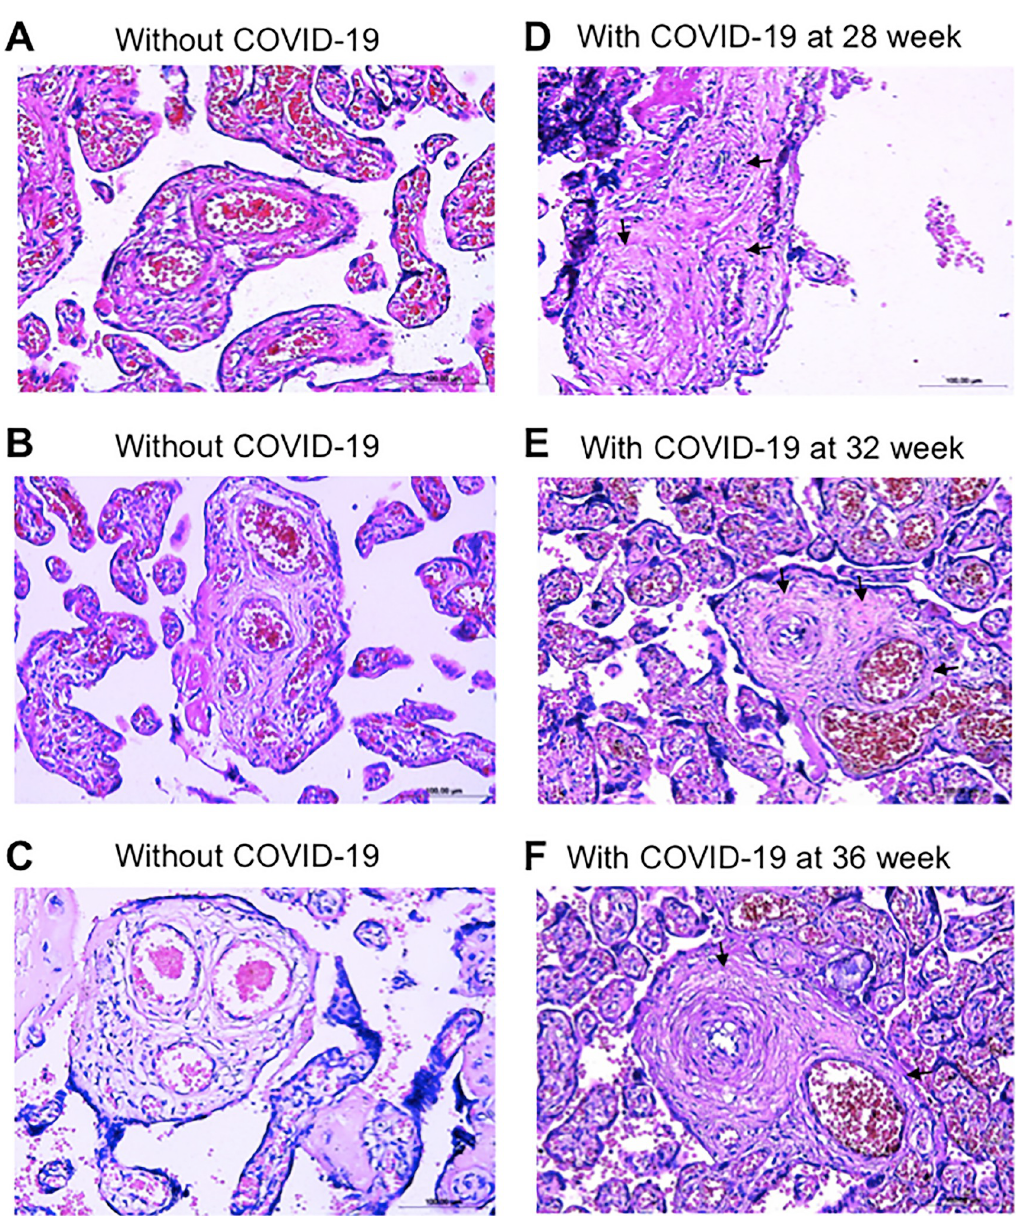
Fig 1. Vascular wall thickening in the placentas of women who contracted COVID-19 during pregnancy. (A-C) H&E staining images of the placental semi-stem villi arteries of three representative women who gave birth without contracting COVID-19 (40 week of gestation). (D-E) H&E staining images of the placental semi-stem villi arteries of three representative women who gave birth (40 weeks of gestation) while contracting COVID-19 at 28, 32, or 36 weeks of gestation. Magnification x200. Arrows indicate remodeled